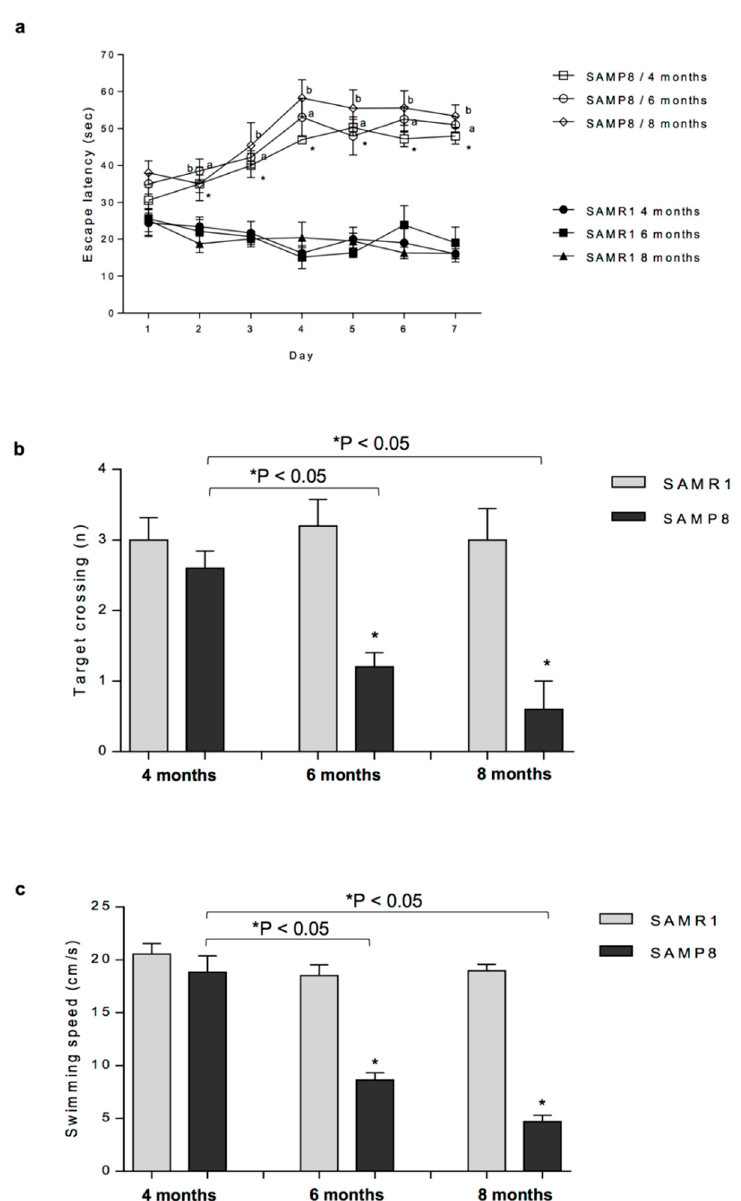
Figure 1. Cognitive performance of SAMR1 and SAMP8 mice at four, six and eight months of age, during the training and probe trial session of the Morris water maze test: ( a ) escape latency in SAMR1 and SAMP8 mice at four, six and eight months of age, during seven consecutive days of Morris water maze test training; ( b ) number of target crossings; and ( c ) swimming speed. Data are expressed as mean ± S.E.M. from eight animals. * p < 0.05, aP < 0.05, bP < 0.05, significant differences vs. age-matched SAMR1. Statistics: two-way ANOVA followed by post hoc analysis with Fisher LSD test (for paired data).